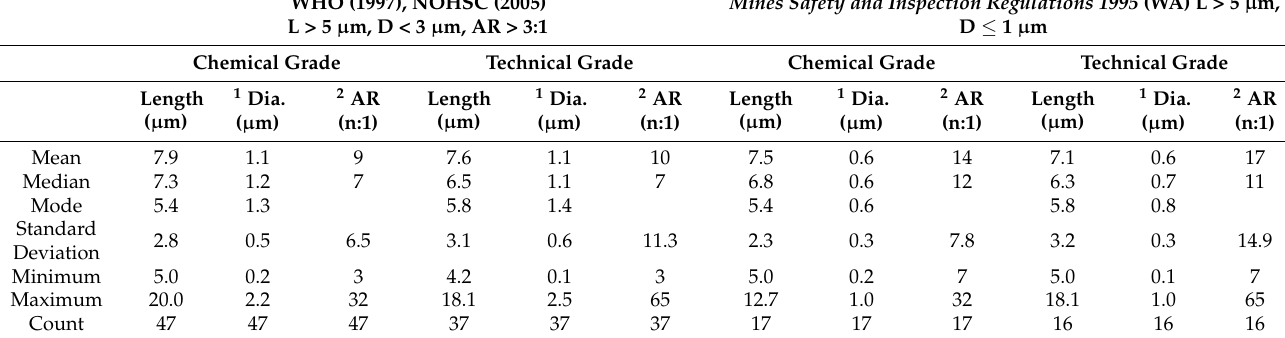
Table 3. Summary of statistics for countable particles in chemical and technical grade α -spodumene concentrate samples that satisfy the two different counting